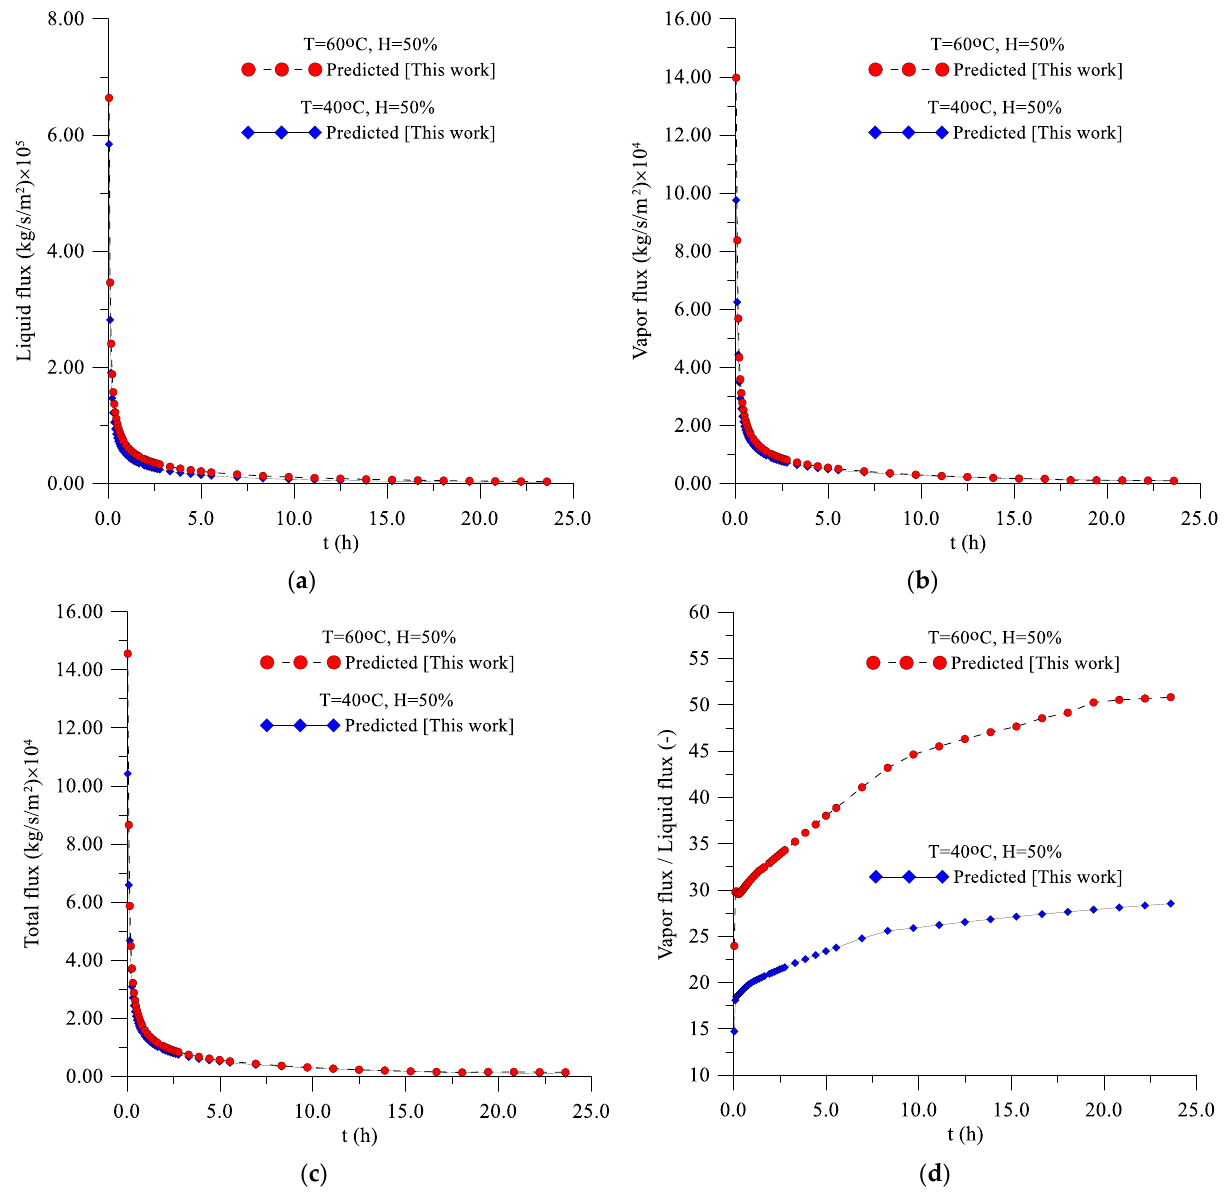
Figure 5. Average temperature of lentil grain over time during drying at 40 °C and 60 °C and a relative humidity of 50%.